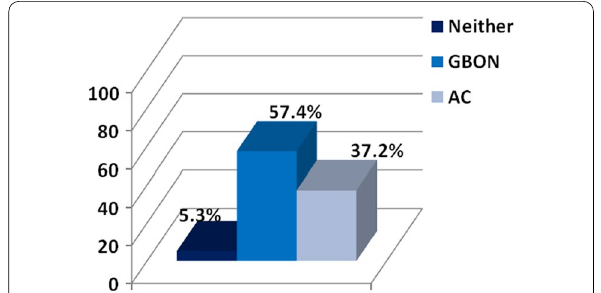
Fig. 1 Opinions of assessors on which index was easier to use